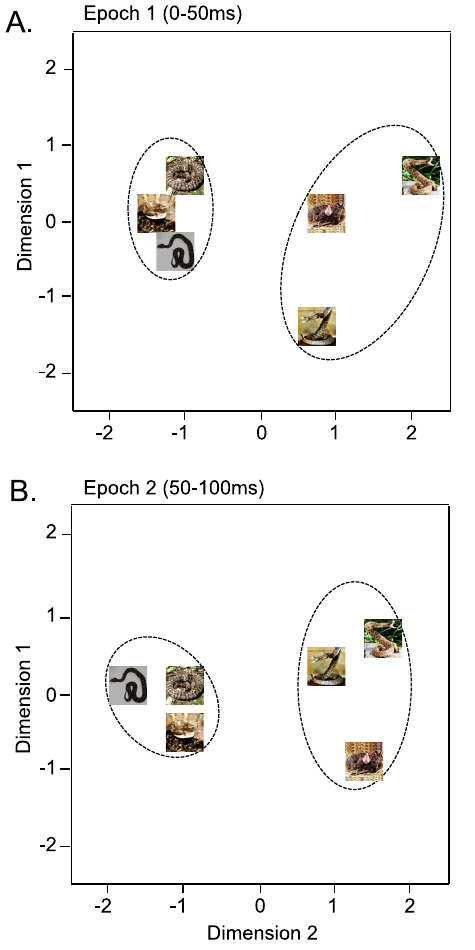
Figure 3. Distributions of the 6 visual stimuli in a two-dimensional space resulting from multidimensional scaling using responses of the 78 neurons to these stimuli in epoch 1 (A), epoch 2 (B). In epochs 1 and 2 (A, B), the snakes in threat display were separated from the non-threat-displaying